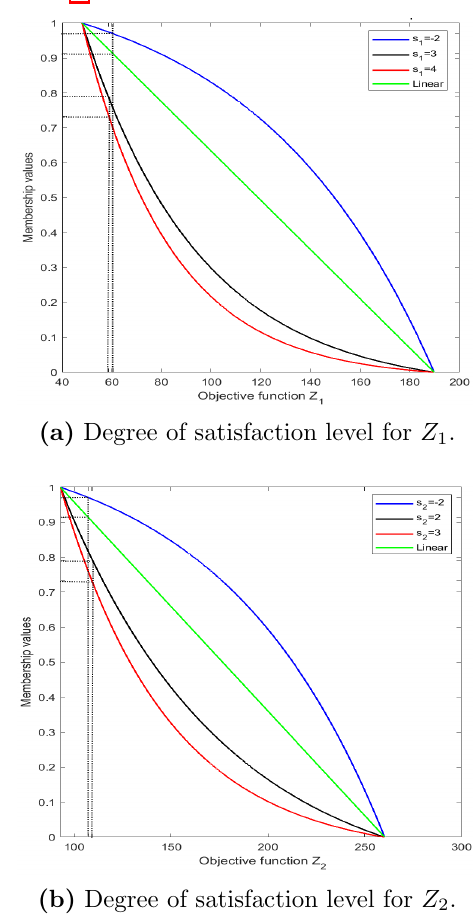
Figure 2. Graphical representation of solutions for OV Model-6 with